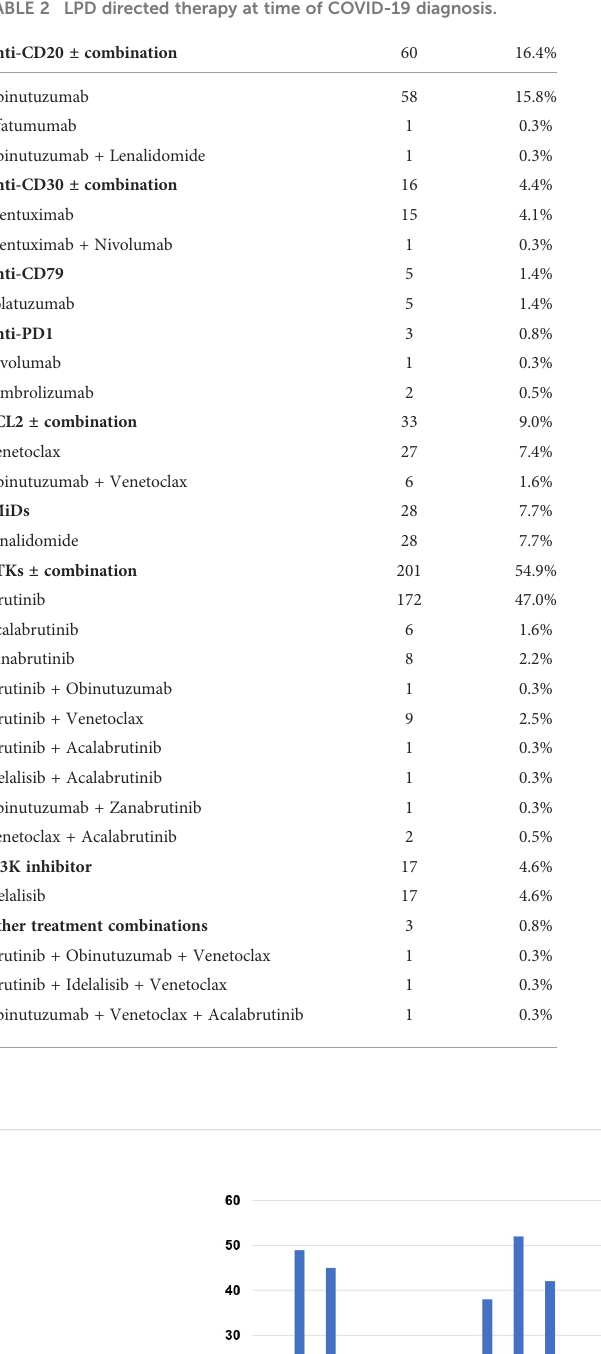
TABLE 2 LPD directed therapy at time of COVID-19 diagnosis.